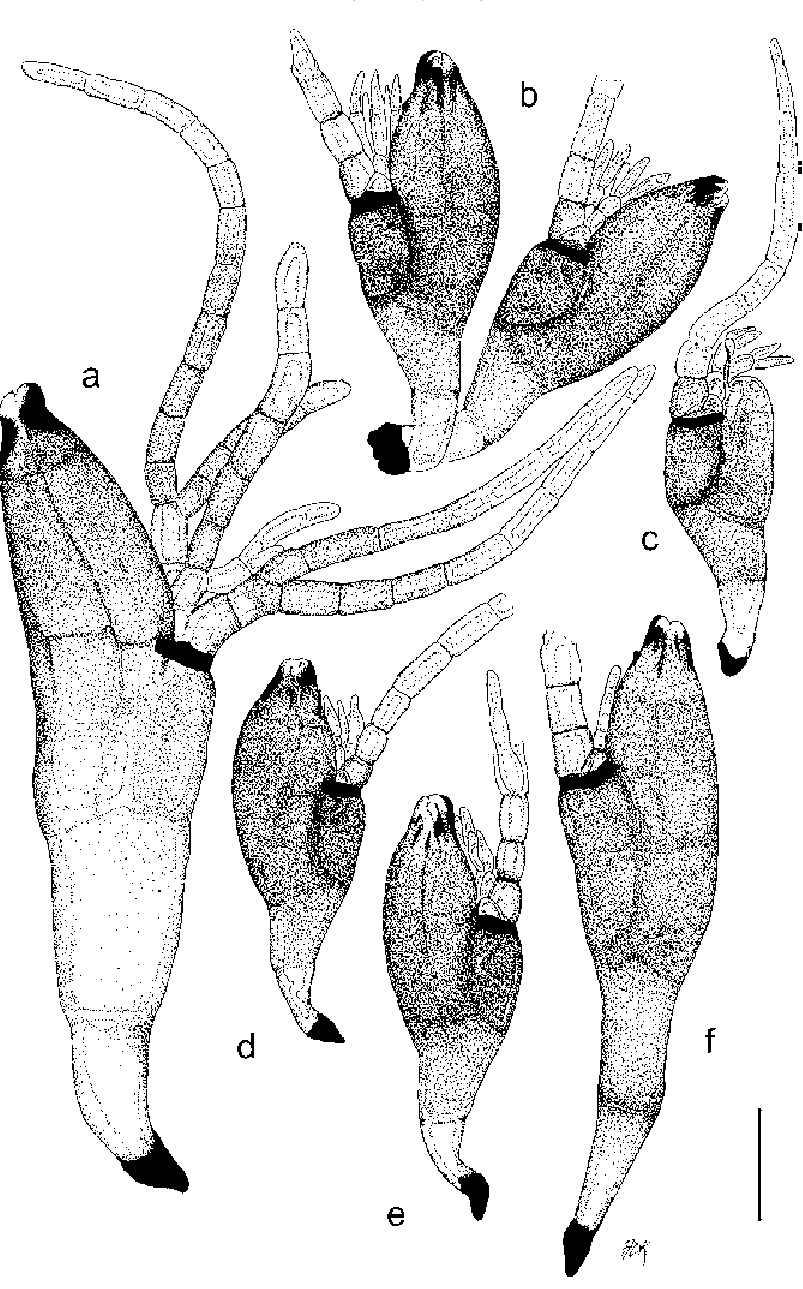
Fig. 1. a. Laboulbenia elaphri Spegazzini from pronotum of male Elaphrus cupreus (DKK43); b e. Laboulbenia elaphricola Siemaszko et Siemaszko, with b,d & e. from pronotum of male Elaphrus riparius (DKK62) and c. juvenile thallus with typical stout habit, taken from right elytron of female Elaphrus riparius (DKK38b); f. Laboulbenia vulgaris Peyr. from elytron of female Bembidion sp. (DKK44). Scale bar =